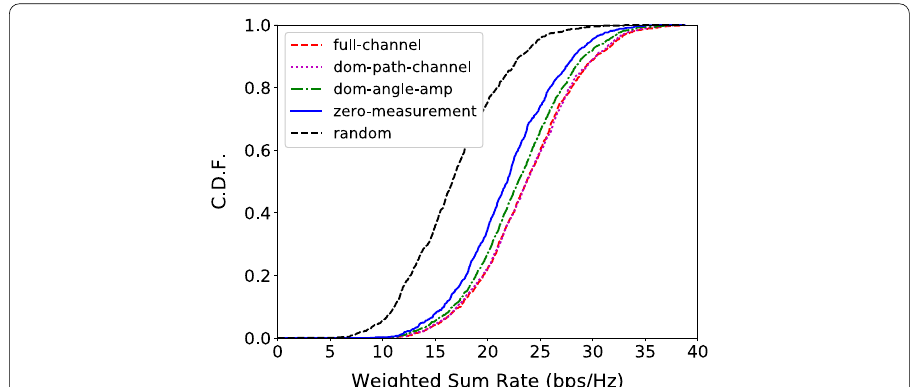
Fig. 5 The cumulative distribution function of weighted sum rate. This includes weighted sum rates with full-channel selection (labeled as full channel), dominant channel paths-based selection (labeled as dom-path-channel), dominant angles and amplitudes-based selection (labeled as dom-angle-amp), zero-measurement selection (labeled as zero-measurement) and uniformly random user selection (labeled as random), respectively, where a 64-antenna base-station selects K = 8 users out of N = 100 users for downlink beamforming based on measured